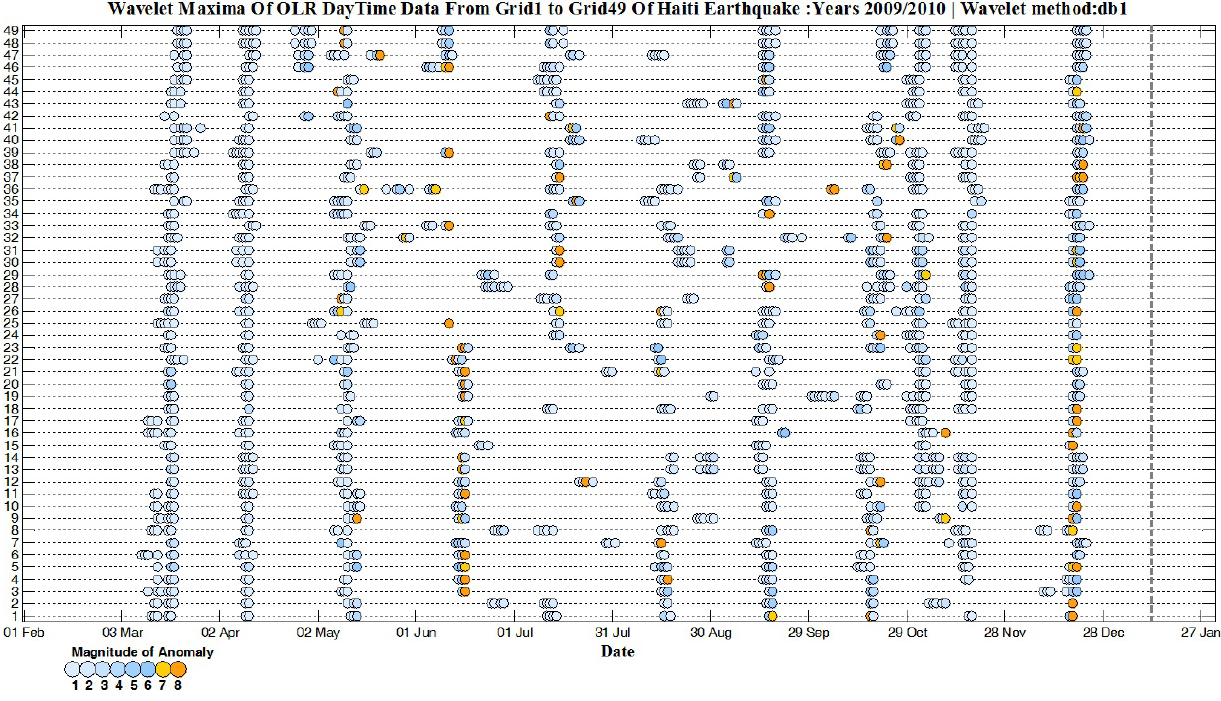
Fig. 6. Wavelet maxima analysis curves from Grid1 to Grid49, with a set of grids of 7 × 7degree of latitude by longitude area over the epicenter, the dashed line indicates the day when the earthquake occurred.